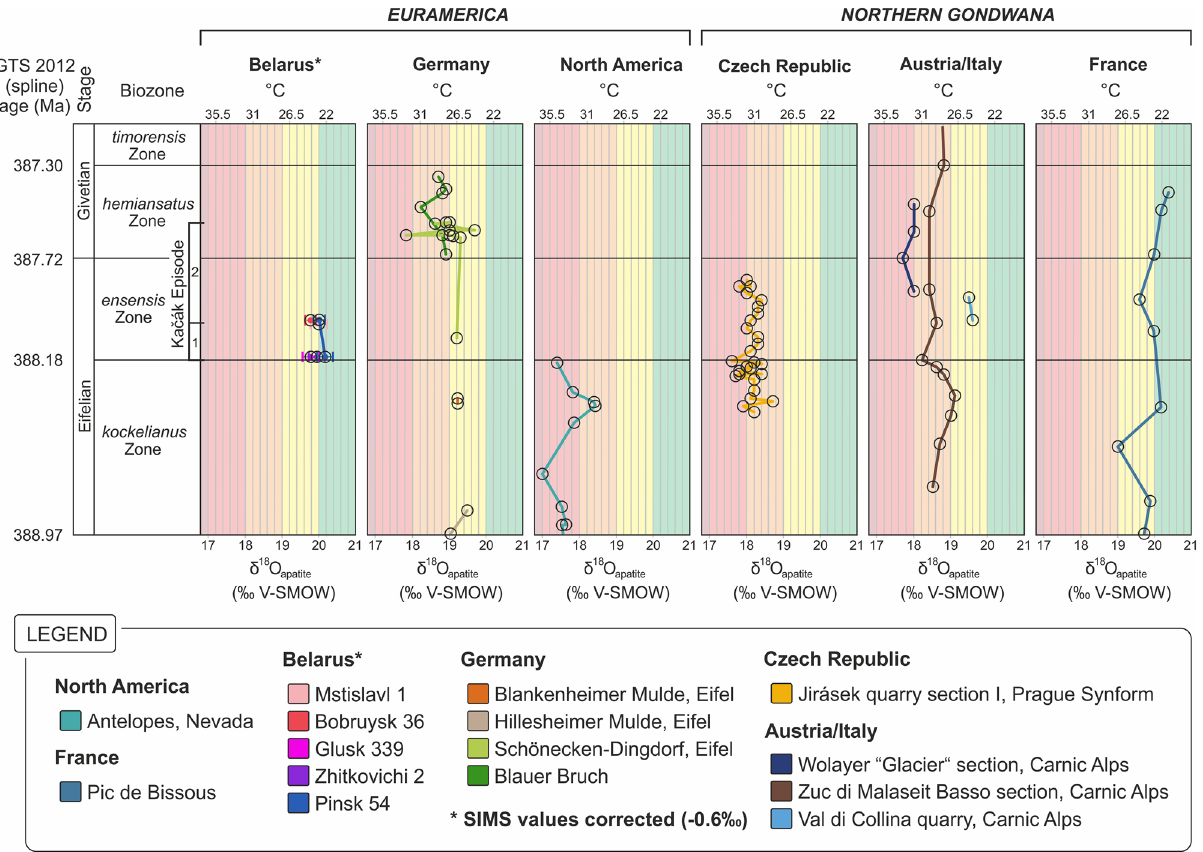
Figure 3. Comparison of δ 18 O apatite isotope records during the late Eifelian and earliest Givetian (North–South sorted). Data from Belarus, Germany, North America and France compiled from Elrick et al. 27 , Joachimski et al. 25 , Königshof et al. 26 and Narkiewicz et al. 28